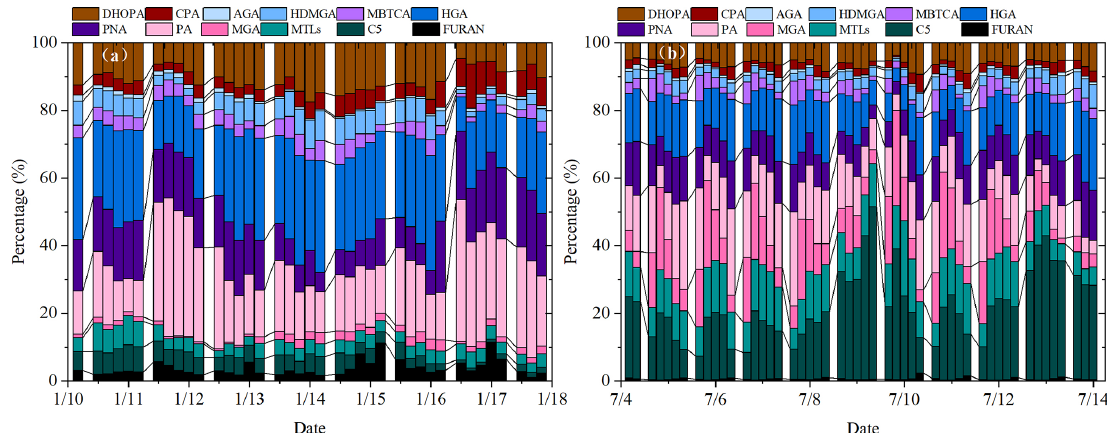
Figure 3. Percentages of isoprene, monoterpene, β -caryophyllene and toluene SOA tracers in winter (a) and summer (b) .